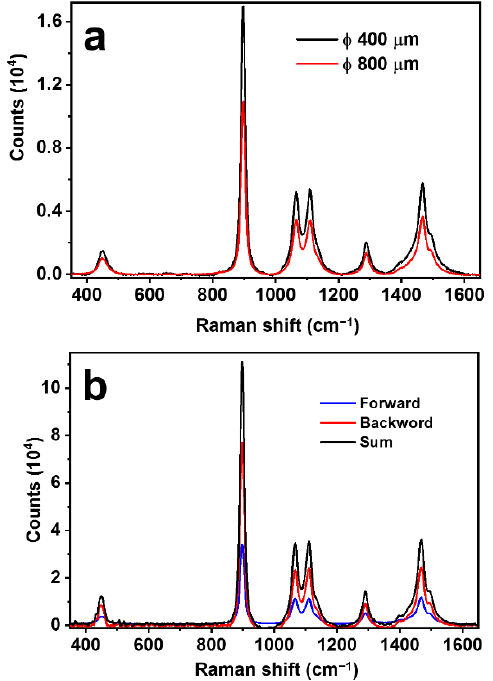
Figure 3. ( a ) Raman spectra measured on pure ethanol using SERS hollow fibers with diameters of 400 and 800 μ m. Employed parameters: focal length = 30 mm, excitation laser power = 200 mW, integration time = 1 s. ( b ) Raman spectra were measured on pure ethanol using a SERS hollow fiber with a diameter of 400 μ m using different collection geometry: forward (blue), backward (red), and bidirectional (black). Employed parameters: focal length = 30 mm, excitation laser power = 450 mW, integration time = 1 s.